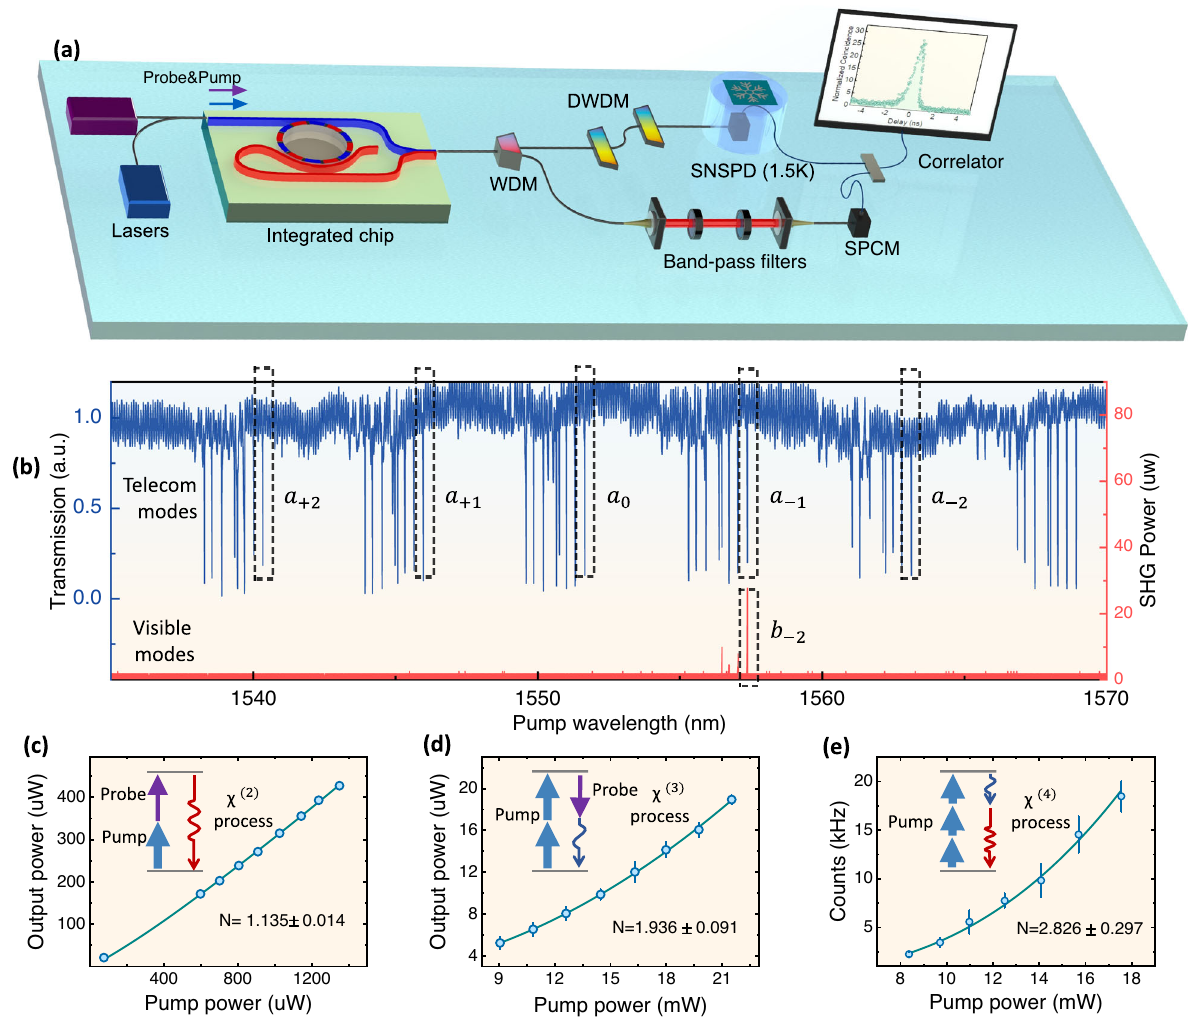
Fig. 2 | Characterization of the nonlinear process. a The experimental setup for 5WM. Telecom pump and probe lasers are coupled into the chip through a fi ber lens and the output signals are collected by another fi ber lens. The visible and telecomsignalphotonsareseparatedbyawavelengthdivisionmultiplexer(WDM), and then fi ltrated from background via a series of band-pass fi lters and dense wavelength division multiplexing (DWDM), respectively. The coincidence of gen- eratedphotonpairsischaracterizedbysinglephotondetectors(SPCMandSNSPD)